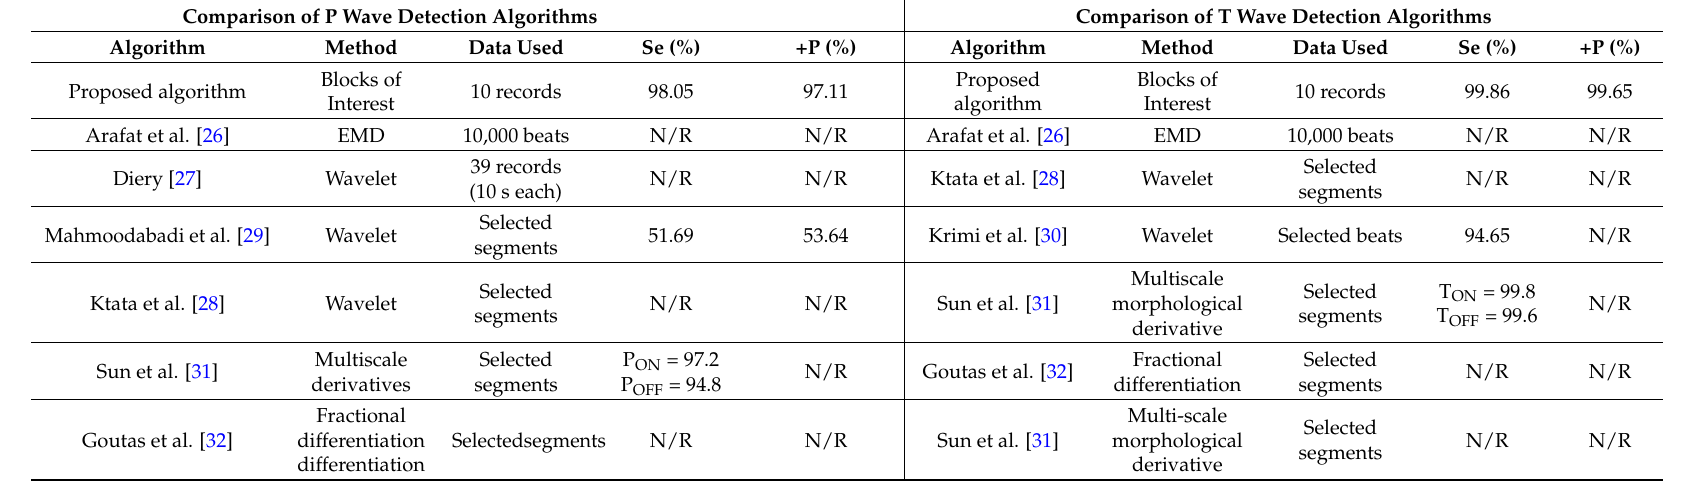
Table 3. Comparison of several P and T wave algorithms on the MIT-BIH Arrhythmia